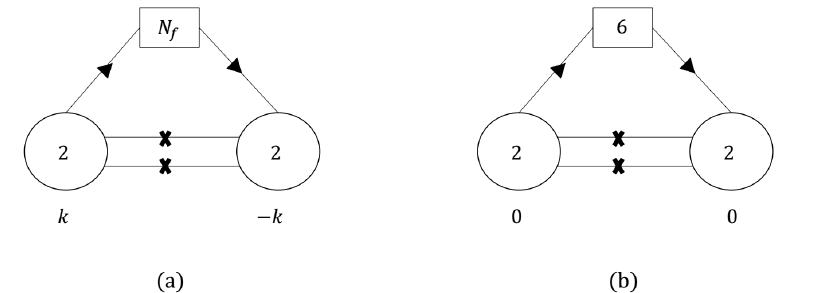
Figure 3 . The 3 d quiver theory associated with the compactification of the 5 d E N on a torus with flux 1 ( p 8 − N f ; 1 , 1 , . . . , 1) . The theory in (a) shows the case of generic N f , 2 with k = 6 − N f , while (b) is specialized to the N f = 6 case. The theory also contains various 2 superpotential interactions. Notably, there are cubic superpotentials running along the triangle as well as the flipping